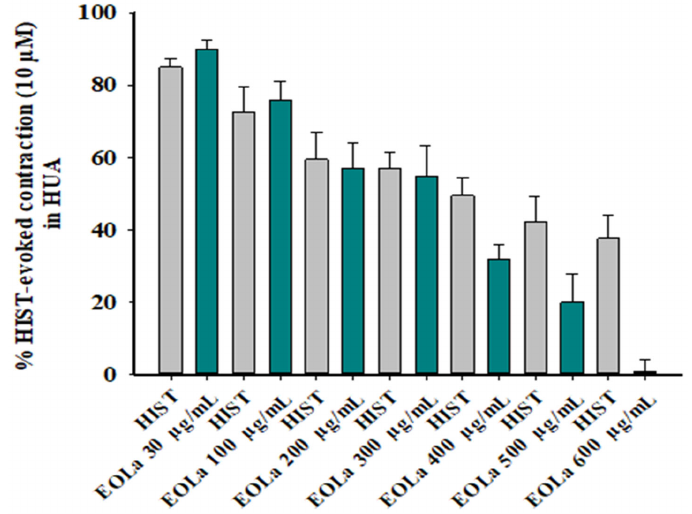
Figure 5. Relaxant effect of EOLa (30–600 µ g/mL) and evaluation of pharmacomechanical coupling by HIST (10 µ M) in HUA. Concentration–response bar graph for the effect of EOLa on contractions induced by histamine in HUA. Values are expressed as the mean ± SEM; n = 6 ( p < 0.01, one ‐ way ANOVA).